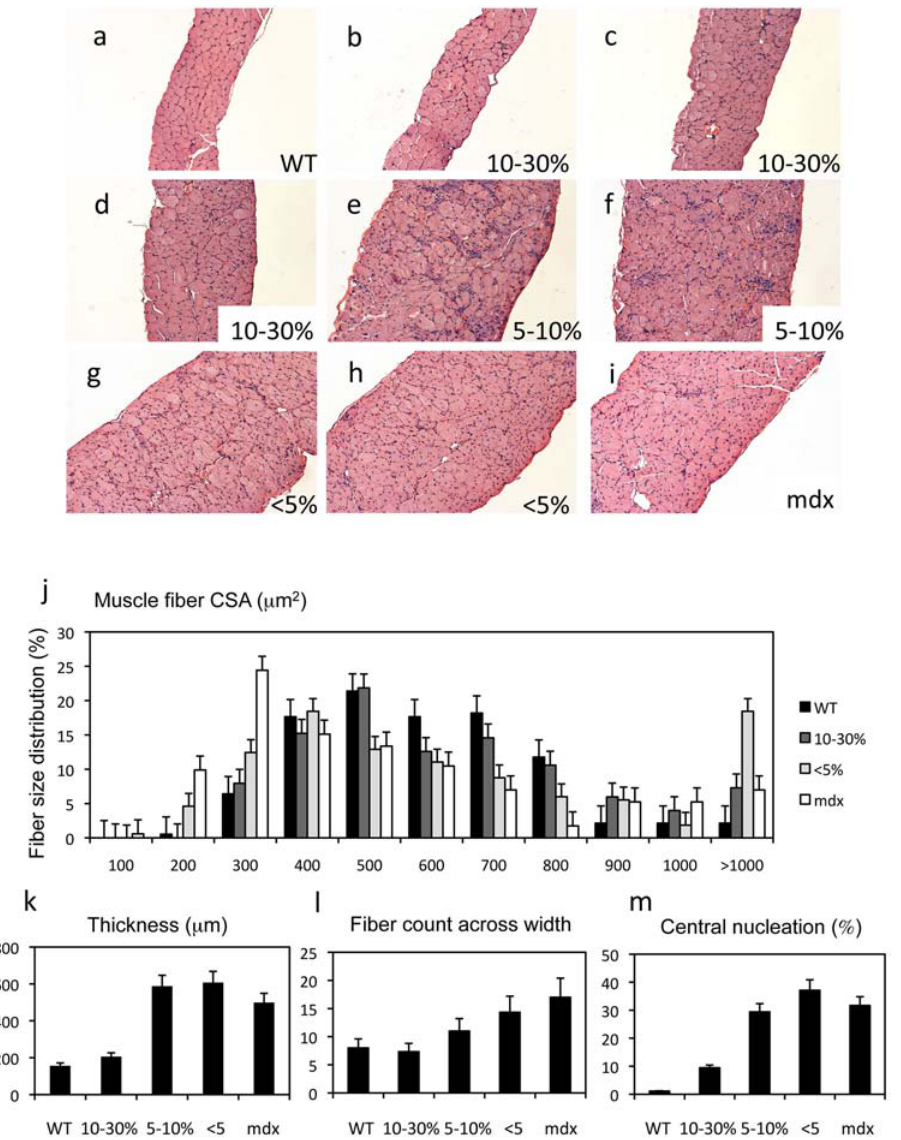
Figure 2. WT/mdx chimeric muscle exhibits improved pathology in a dose-dependent manner. a–i, Diaphragms from 4 month-old WT (a), 10–30% WT/mdx chimeric (b–d), 5–10% WT/mdx chimeric (e–f), less than 5% chimeric WT/mdx (g, h) and an mdx (i) mice were paraffin sectioned and H&E stained. j–m, fiber size distribution (j), thickness (k), fiber count across the diaphragm width (l) and percentage of central nucleation (m) measurements. Note that the thickness, the number of fibers across the diaphragm width or the percentage of central nucleation depends on the percentage of ESCs incorporated. Two or three diaphragm muscles per animal per group (WT [n=3], mdx [n=3], 10–30% WT/mdx [n=3], 5–10% WT/ mdx [n=2] and , 5% WT/mdx [n=3]) were analyzed. At least 200 fibers were analyzed per animal per group for the studies indicated in (j) and (m). 20 measurements of thickness, with the corresponding number of fibers, per animal per group were performed in the studies indicated in (k) and (m). Magnification of a–i: 100 6